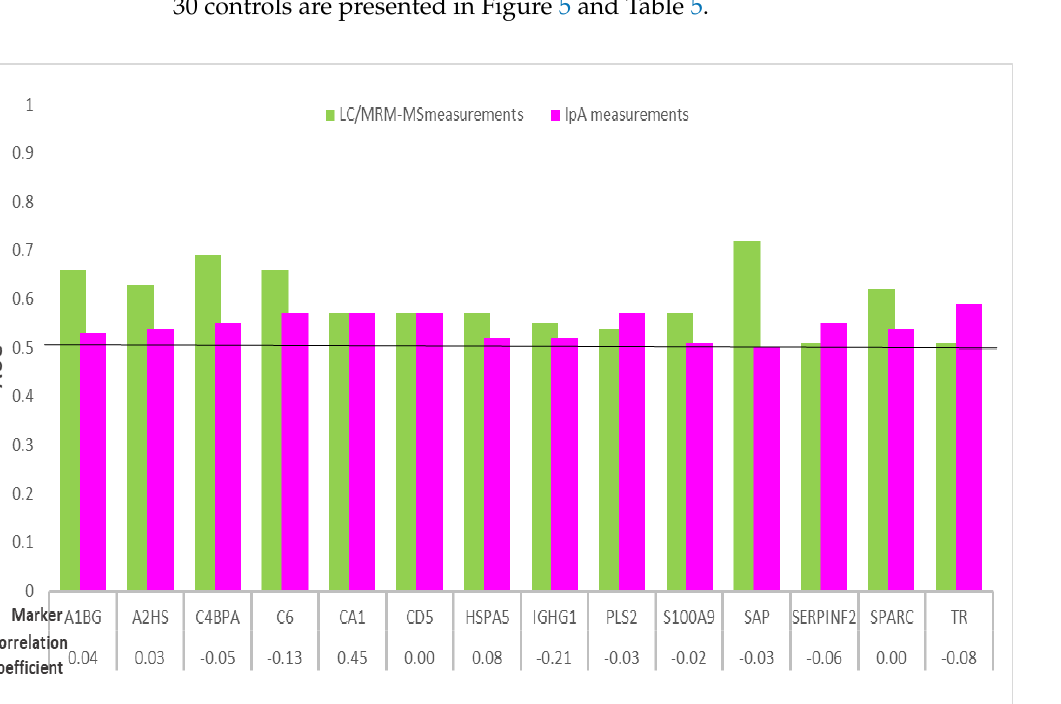
Figure 5. Distribution of AUCs of 14 protein biomarkers overlapping between LC/MRM-MS and IpA measurements for detecting CRC cases from participants in screening colonoscopy. Abbreviations: A1BG, alpha-1B-glycoprotein; A2HS, alpha-2-HS-glycoprotein; AUC, area under the receiver operating curve; C4BPA, C4b, binding protein alpha chain; C6, complement component C6; CA1, carbonic anhydrase 1; CD5, CD5 antigen; CRC, colorectal cancer; HSPA5, 78 kDa glucose-regulated protein; IGHG1, immunoglobulin gamma-1 chain C region; IpA, immunome protein array; LC/MRM-MS, liquid chromatography/multiple reaction monitoring–mass spectrometry; PLS2, plastin-2; S100A9, protein S100-A9; SAP, serum amyloid P-component; SERPINF2, alpha-2-antiplasmin; SPARC, secreted protein acidic and rich in cysteine; TR, transferrin receptor protein 1.